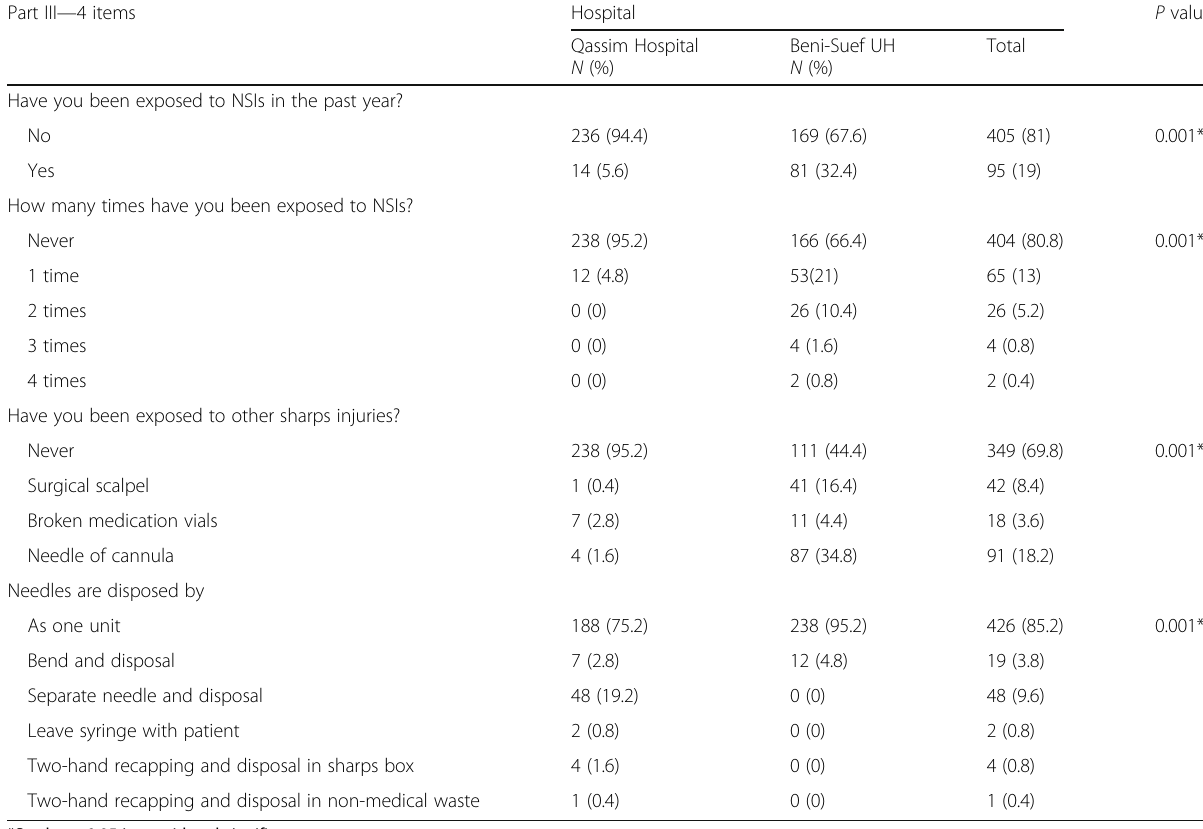
Table 6 Exposure to needlestick injuries (NSIs) and methods of needle disposal Part III — 4